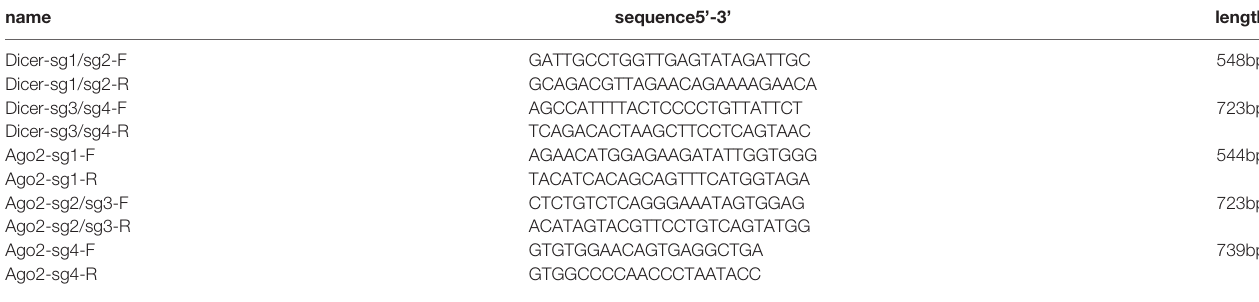
TABLE 2 | Ampli fi ed primer